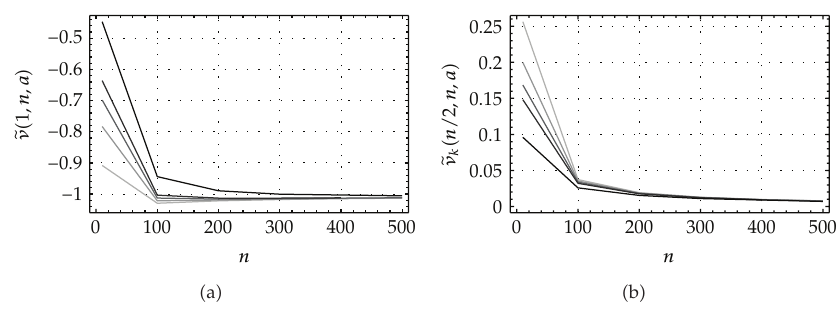
Figure 3: Dependence of (cid:2) ν (cid:2) 1 ,n,a (cid:3) and ∂ (cid:2) ν (cid:2) k,n,a (cid:3) /∂k | k (cid:4) n/ 2 on n for a (cid:4) 10 , 20 , 30 , 40 , 100. Plots are shown in gray-level intensity, from lower to higher, according to the value of a